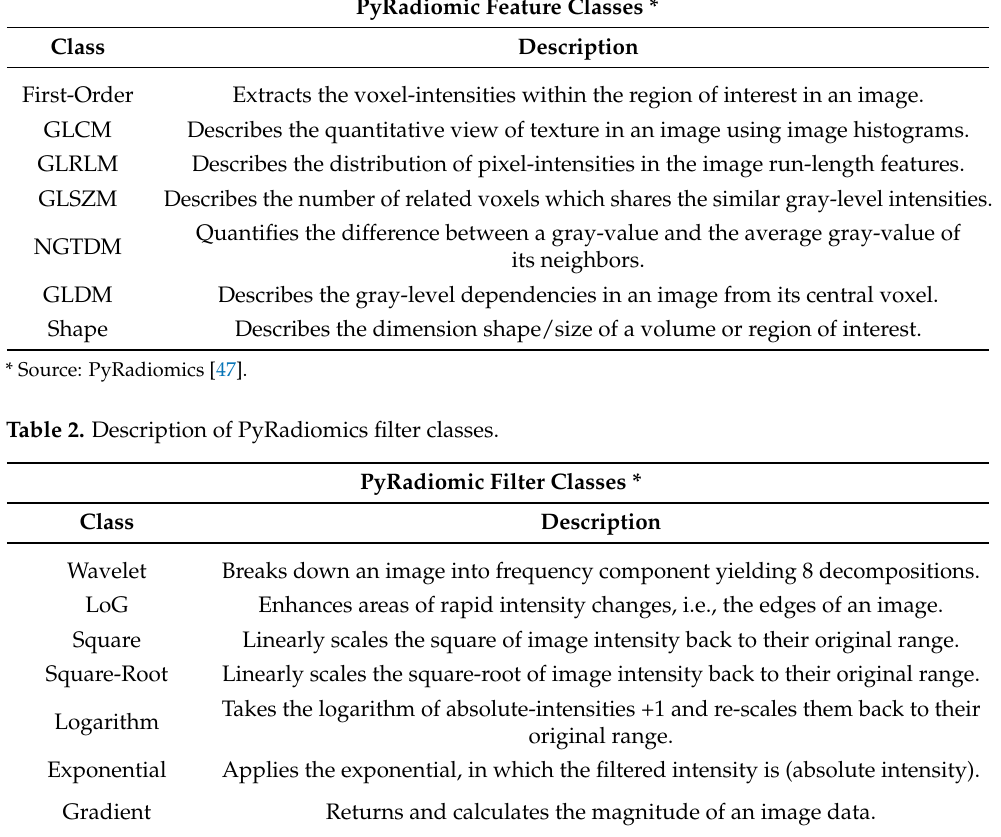
Table 1. Description of PyRadiomics feature classes. PyRadiomic Feature Classes *